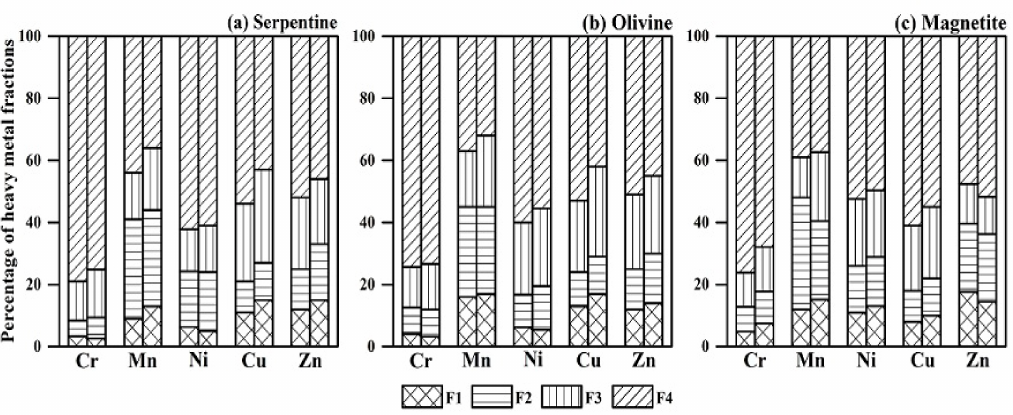
Figure 2. Speciation distributions of heavy metals in different tailing soils. ( a ) Serpentine, ( b ) Olivine and ( c ) Magnetite tailing soils before and after growth of Imperata Cylindrica . The vertical bars with patterns for each metal in the left and the right represent samples of bulk and rhizosphere tailing soils. The meanings of F1, F2, F3 and F4 are shown in Section